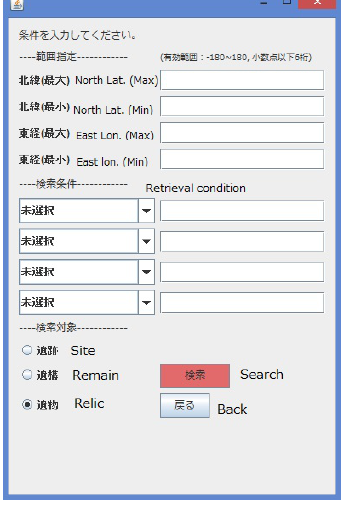
Fig. 10. Initial search window.